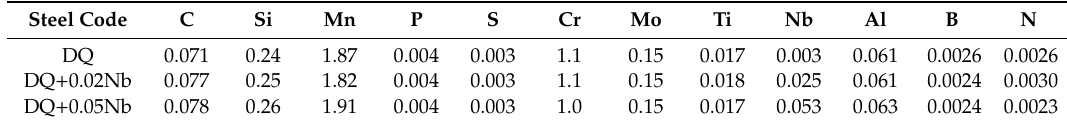
Table 1. Chemical compositions of the investigated steels in